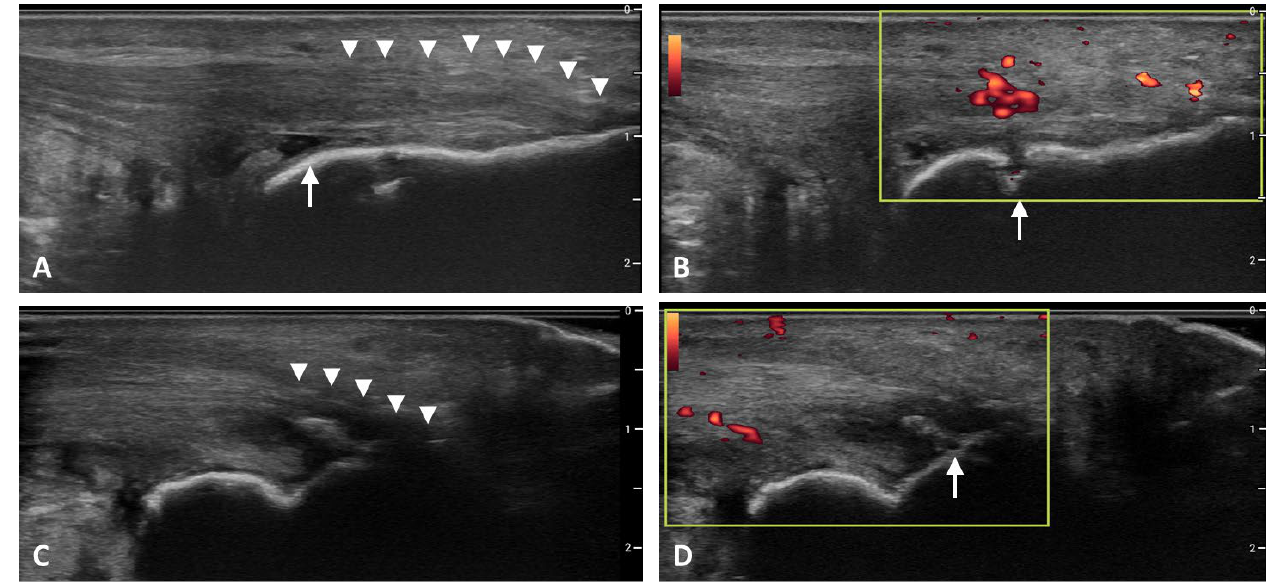
Figure 2. Ultrasound Findings in Enthesitis. ( A ). Entheseal thickening (arrowheads) and retrocalca- neal bursitis (arrow). ( B ). Power Doppler signal adjacent to entheseal insertion and erosion (arrow). ( C ). Hypoechogenicity (arrowheads). ( D ). Enthesophyte/calcification. Images of Achilles enthesitis in gray scale and power Doppler.